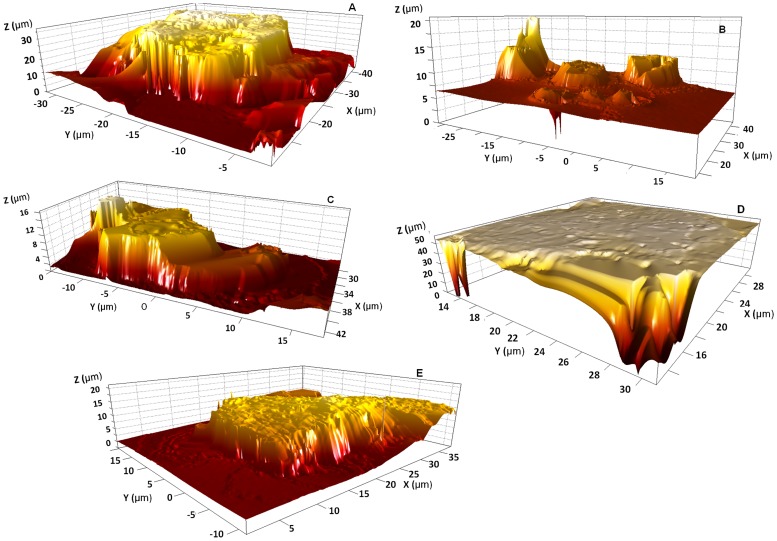
Interferometer topographical images of (A) cohesive MCC, (B) non-sieved starch, (C) cohesive starch, (D) non-sieved pregelatinised starch and (E) cohesive pregelatinised starch.